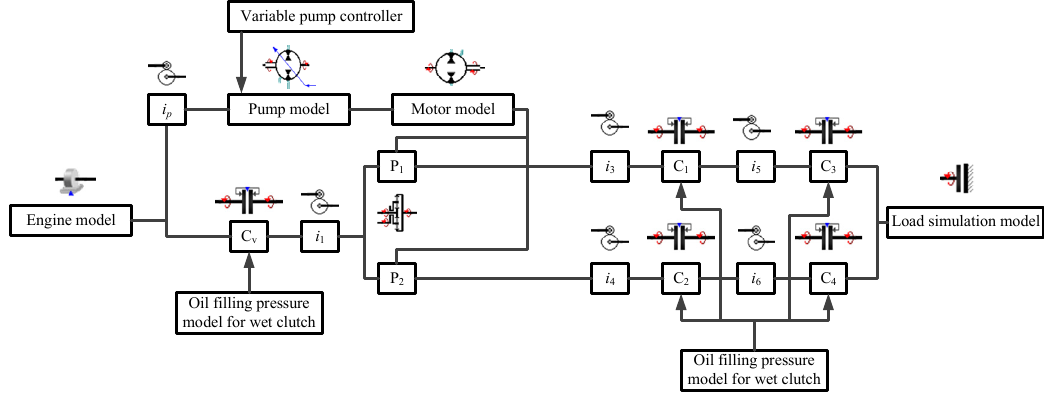
Figure 2. Schematic diagram of the simulation test platform used in this paper.